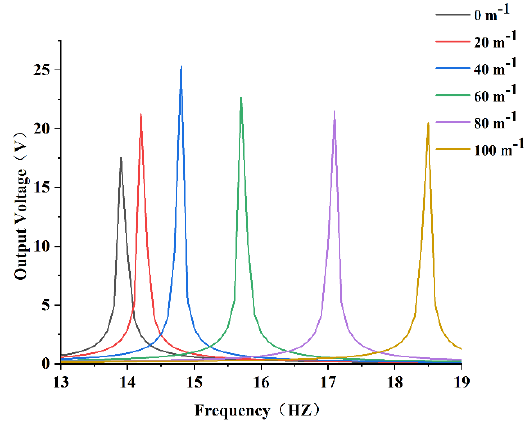
Figure 12. Output